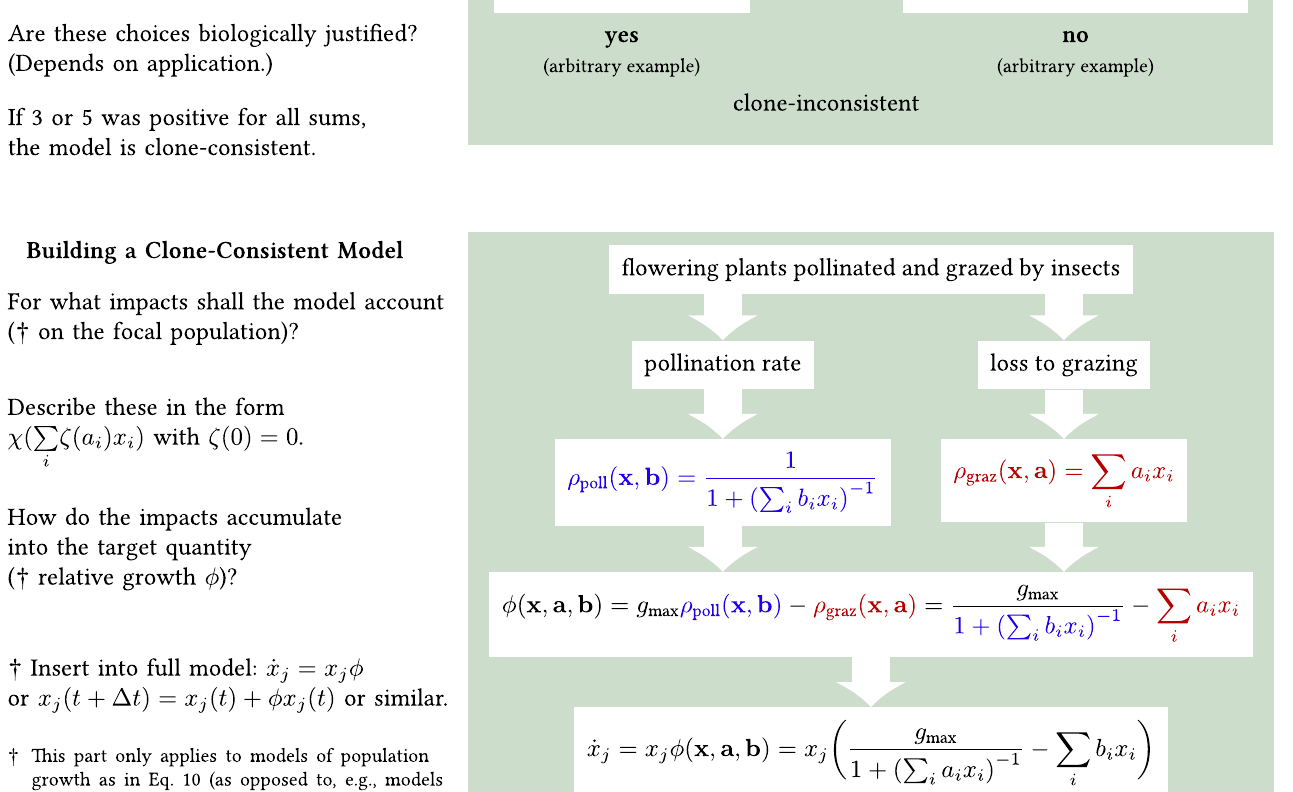
denotes the abundance of population i , and a i